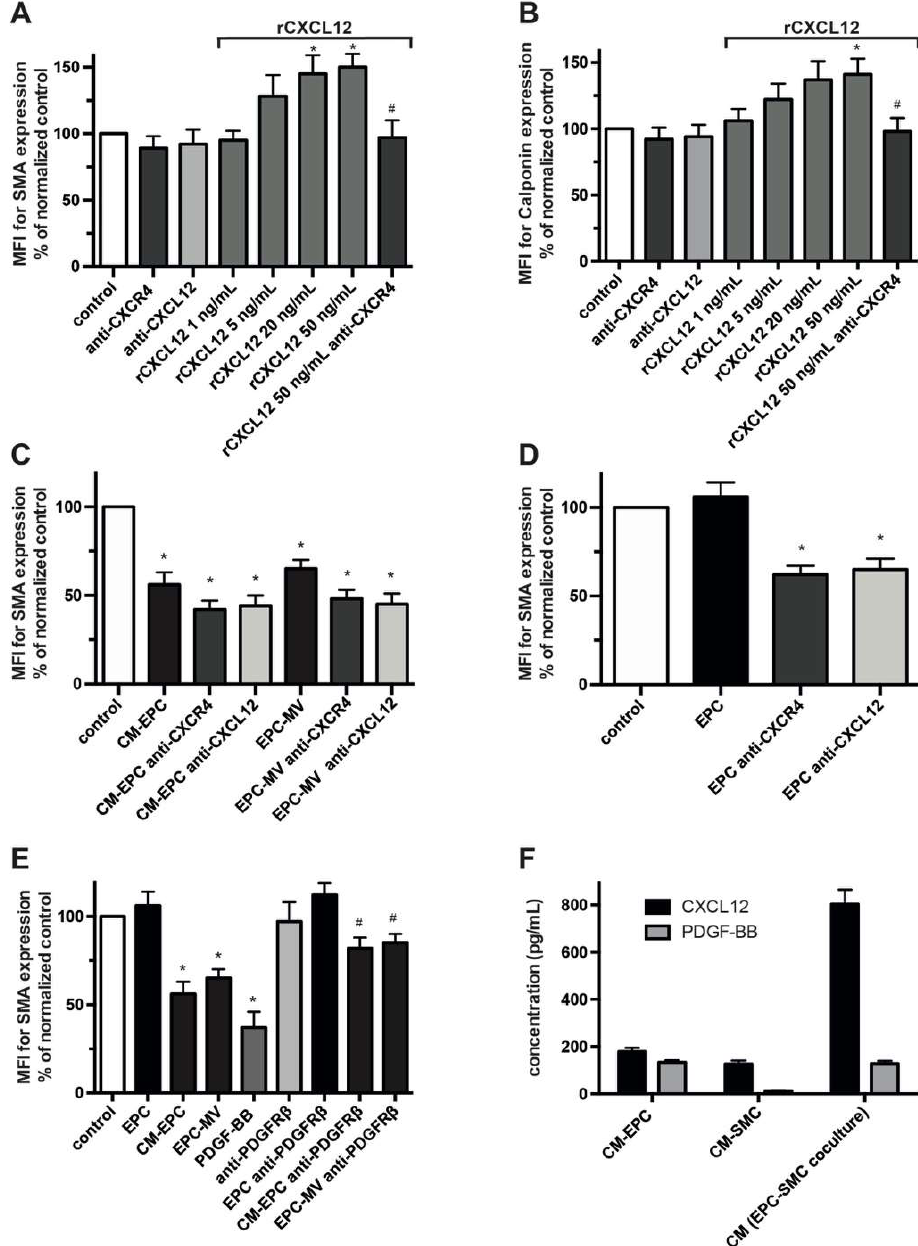
Figure 5 . CXCL12–CXCR4-dependent control of SMC phenotype. ( A – E ) Analysis of EPC-mediated modulation of SMC phenotype and the involvement of the CXCL12–CXCR4 axis. SMCs were treated as indicated for 48 h and presence of SMA and Calponin was measured using flow cytometry. Data are expressed as mean fluorescence intensity (MFI) in % normalized to untreated SMCs (control). ( A – C ) * p < 0.05 vs. control and # p < 0.05 vs. SMCs treated with rCXCL2 50 ng/mL, ( D ) * p < 0.05 vs. SMCs co-cultured with EPCs, ( E ) * p < 0.05 vs. control and # p < 0.05 vs. the respective treatment of SMCs with CM-EPC or EPC-MV in the absence of anti-PDGFRß; n = 4 to 6. ( F ) Comparison of CXCL12 and PDGF-BB released by monocultured EPCs, monocultured SMCs and EPC-SMC co-cultures. Secreted paracrine factors present in the supernatant of the respective cultures were assessed using ELISA; n =